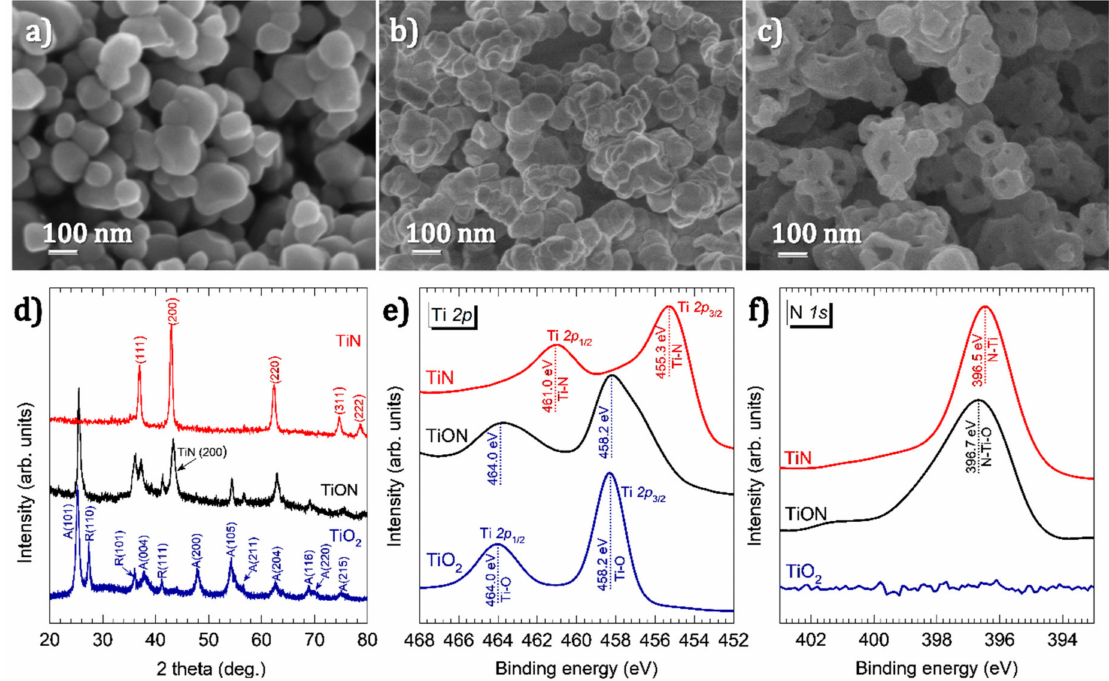
Figure 1. SEM images of ( a ) the TiO 2 powder obtained directly from the hydrofluoric acid leaching process and ( b ) after annealing the powder in NH 3 at 700 ◦ C and ( c ) after annealing at 900 ◦ C; ( d ) XRD patterns of the powders in images ( a – c ), labelled as TiO 2 , TiON and TiN, respectively; XPS spectra of TiO 2 , TiON and TiN ( e ) at the Ti 2p binding energy and ( f ) at the N 1s binding energy.